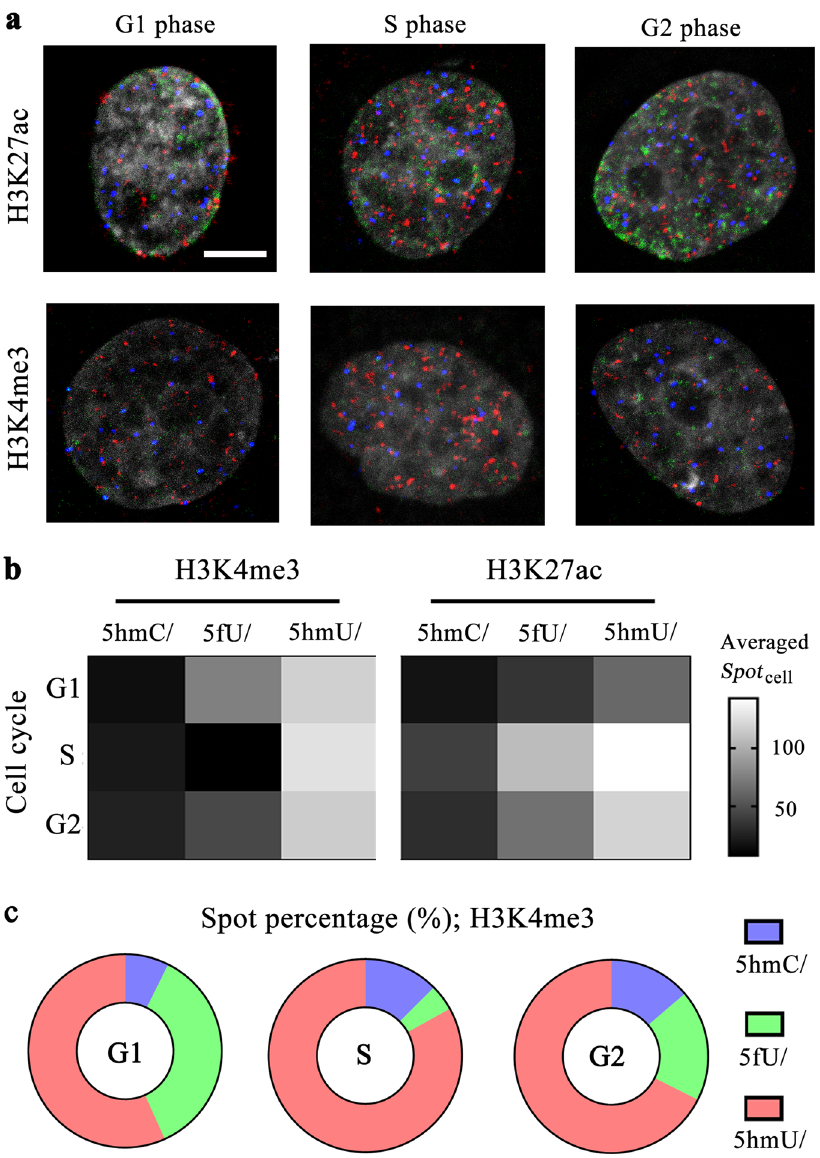
Fig. 5 Dynamic changes of nanoenvironments of chromatin modi fi cations during cell cycles. a Selected merged cell images for three phases of cell cycle. The scale bar is 5 μ m. b The changes of the averaged single-cell spot counts of three combinational chromatin modi fi cations. The cell numbers of G1, S, and G2 phases are each 45, 43, and 52 for H3K4me3, and 38, 37, and 50 for H3K27ac. c The spot percentages of three combination sites of single